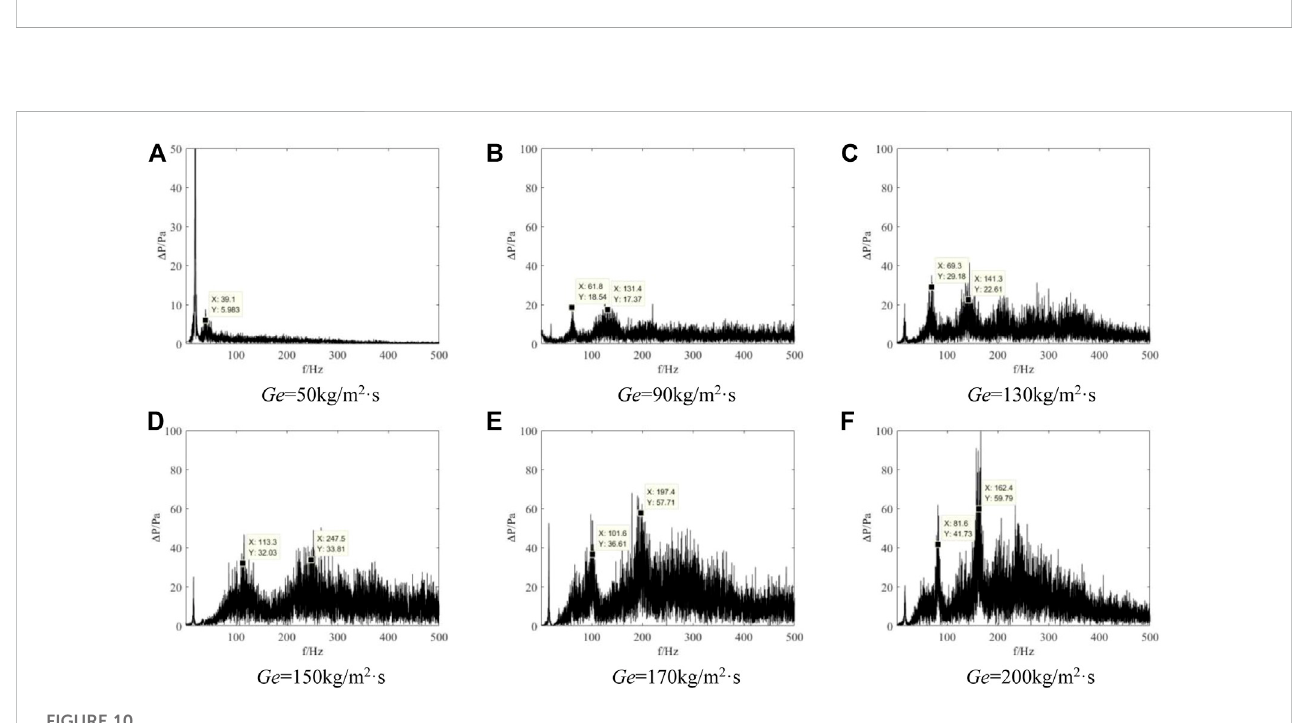
FIGURE 10 Noise frequency-domain signal at Δ T = 11 °